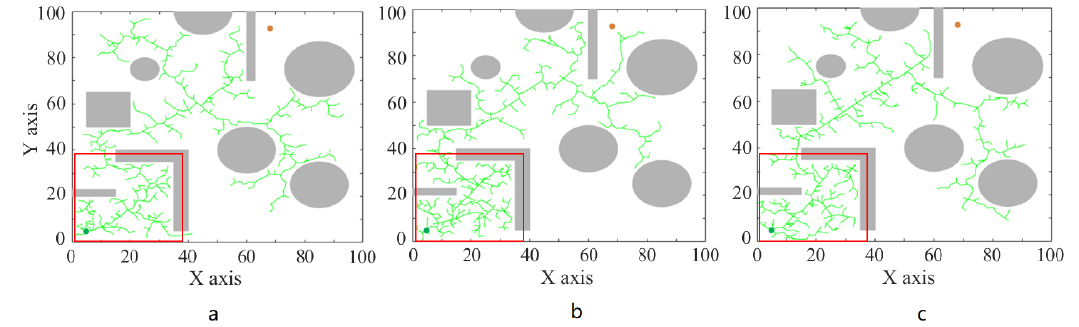
Figure 5. Expanded tree with greedy strategy (( a ) α = 0.9, step = 2, sampling times = 500, collision detection times = 1536; ( b ) α =0.7, step = 2, sampling times = 500, collision detection times = 2394, ( c ) α = 0.5, step = 2, sampling times = 500, collision detection times = 3956).